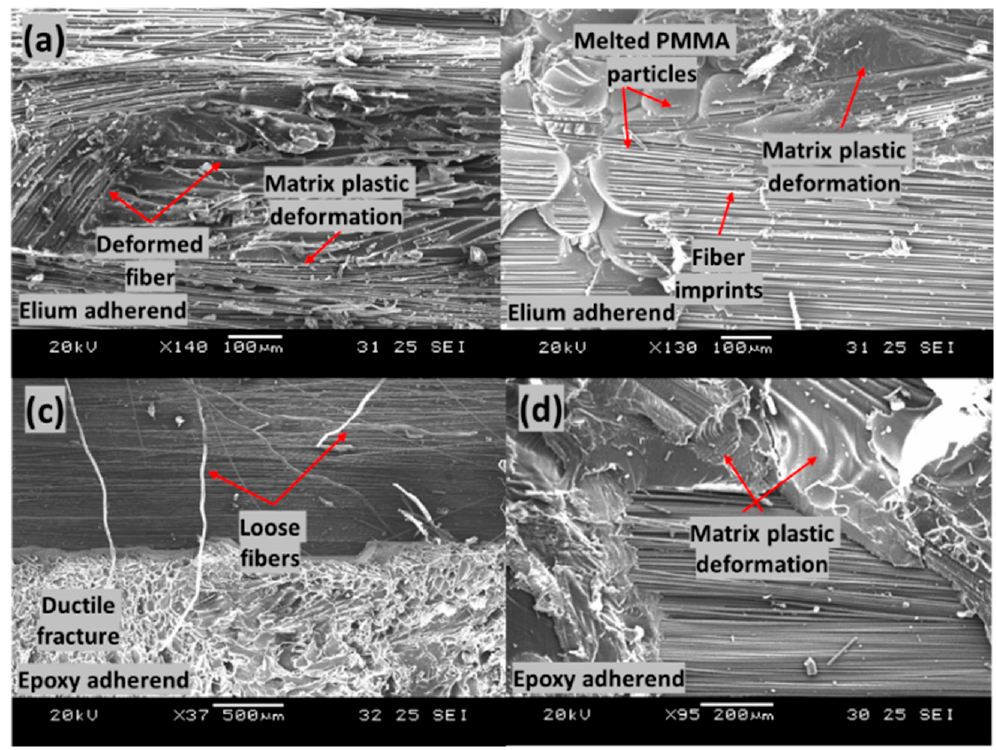
Figure 19. Scanning Electron Microscope fractography of EL-EP(Elium ® -Epoxy)_0.25_0.25 with maximum LSS. ( a , b ) Elium adherend and ( c , d ) epoxy adherend.